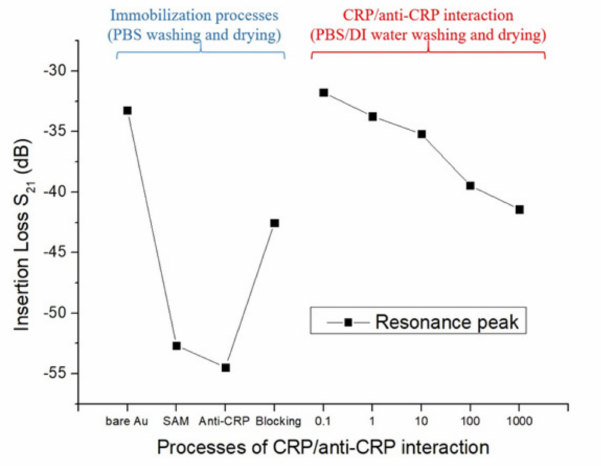
Figure 8. The detailed characterization of the biomolecular membrane modification during the preparation and the subsequent CRP / anti-CRP